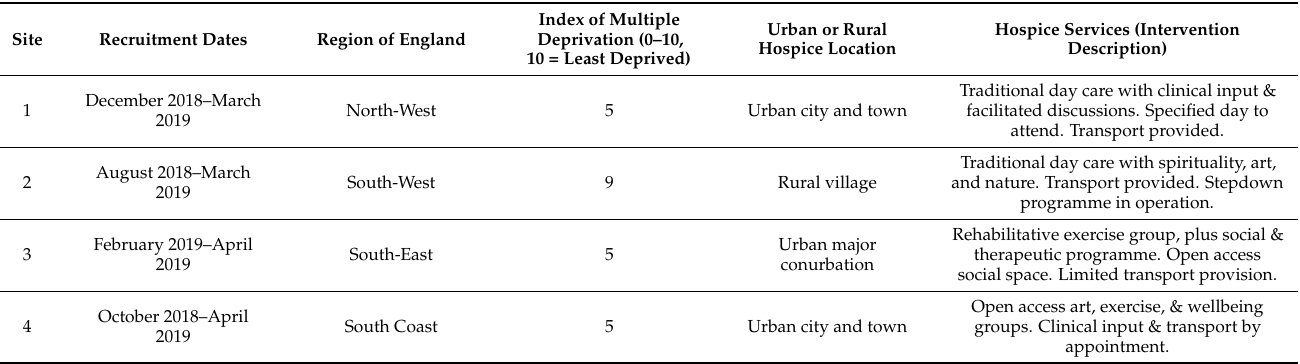
Table 1. Research locations. Note: index of multiple deprivation is according to hospice postcode (postal